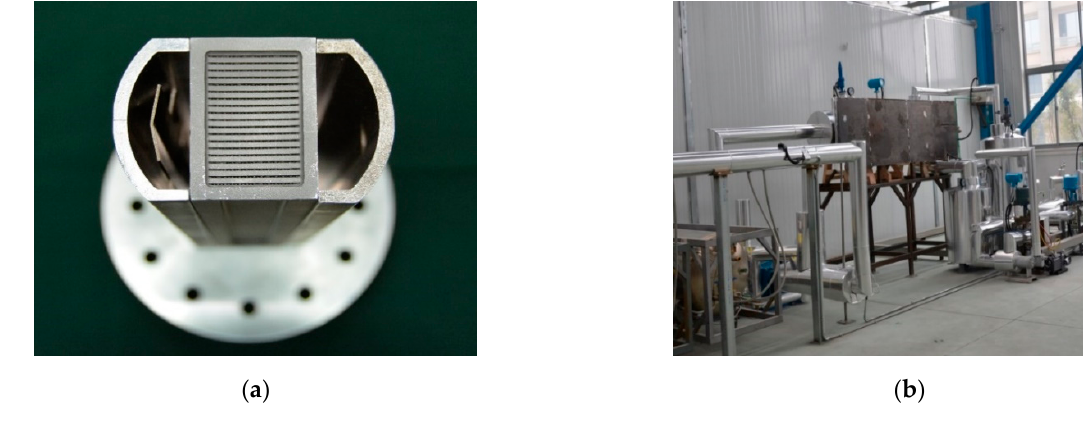
Figure 5. Diagrams of ( a ) experimental PCHE; ( b ) system. Table 3. Comparison between numerical and experimental data.